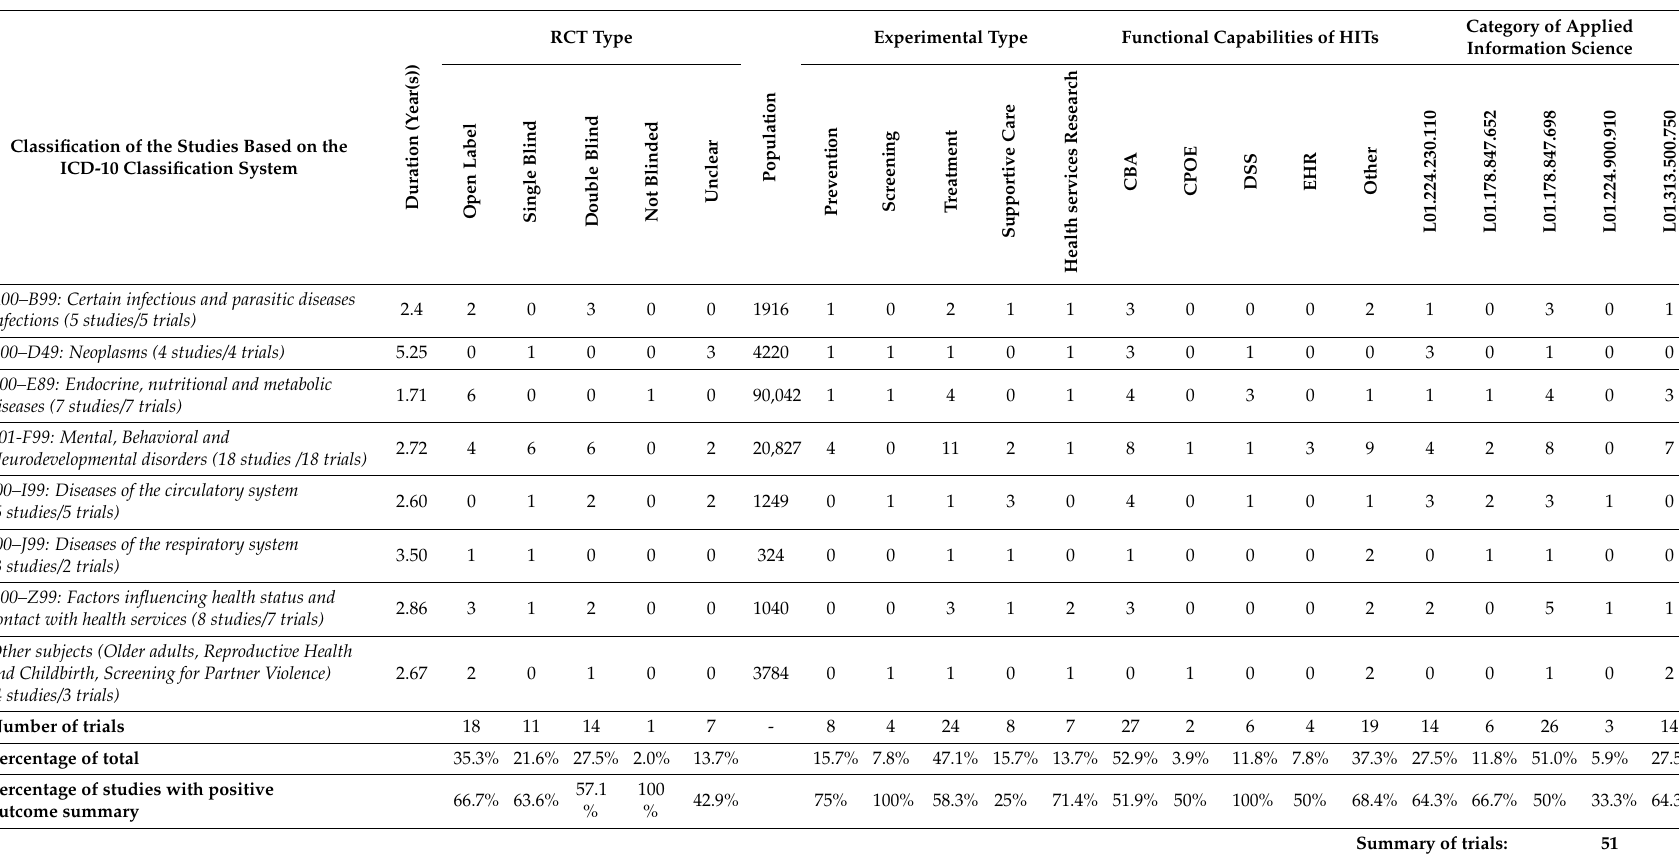
Table 2. Number and percentage of RCT type, experimental type, functional capabilities of HITs and categories of applied information science for the trials according to ICD-10